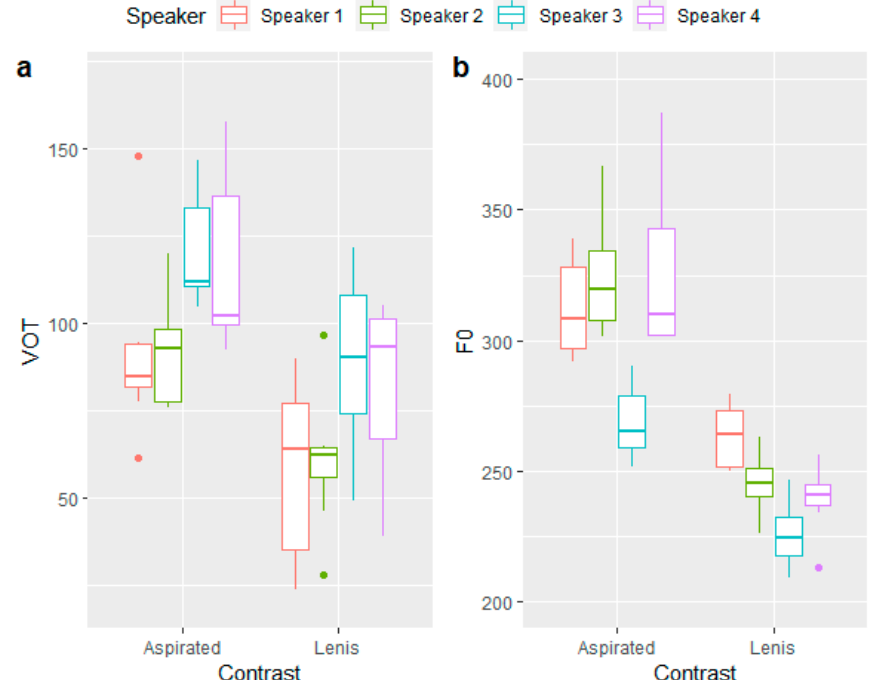
Figure 4. Box plots of the lenis–aspirated stop contrast separated by speaker. ( a , b ) show a comparison of VOT and F0, respectively.